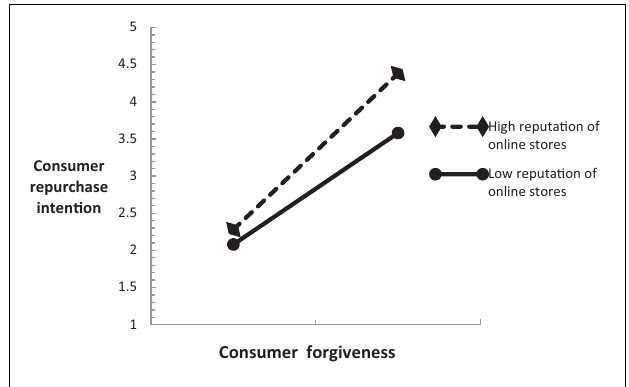
FIGURE 2 | Moderating effect